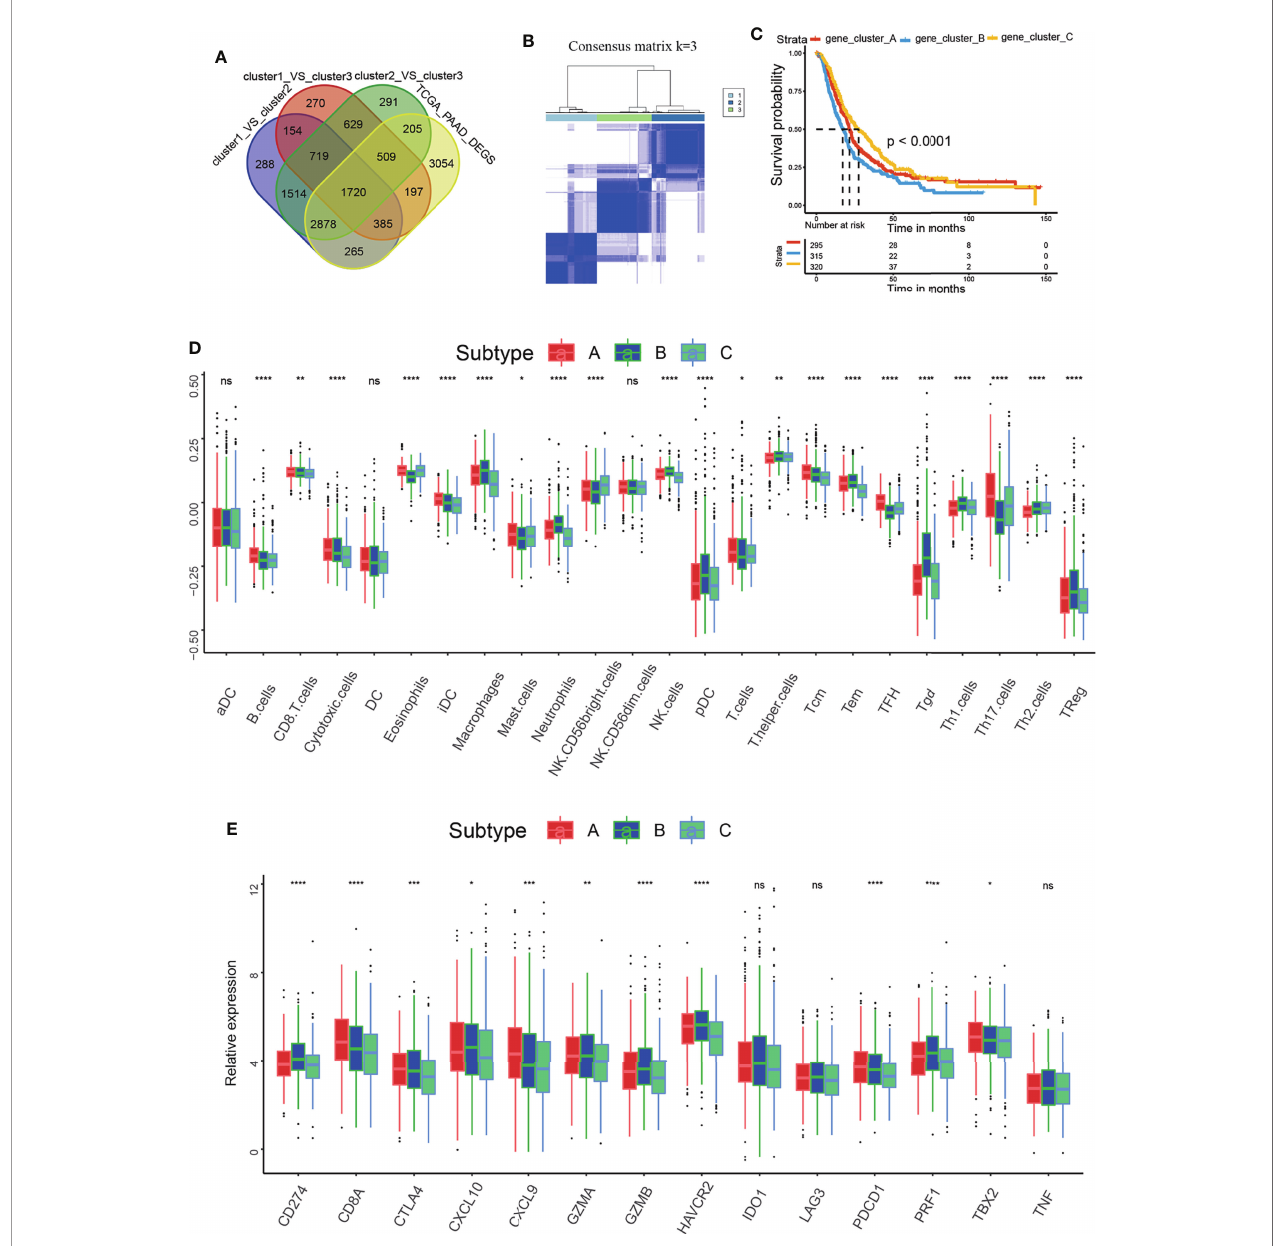
FIGURE 4 | Identi fi cation of the m5C-related gene clusters and analysis of the correlation between the gene clusters and the immune microenvironment. (A) Venn diagram delineating the DEGs between the three m 5 C clusters and the DEGs between non-tumor and tumor samples from PAAD patients of GEPIA dataset. (B) Consensus clustering matrix for k=3. (C) Kaplan – Meier curves of overall survival (OS) for patients with PAAD in m 5 C gene clusters A, B and C. (D) Immune cell in fi ltration in m 5 C gene clusters A, B and C. (E) Expression of immune activation-related genes and immune checkpoint-related genes in m 5 C gene clusters A, B and C. * represents p value < 0.05, ** represents p value < 0.01, *** represents p value < 0.001, **** represents p value < 0.0001, ns means "not statistically signi fi